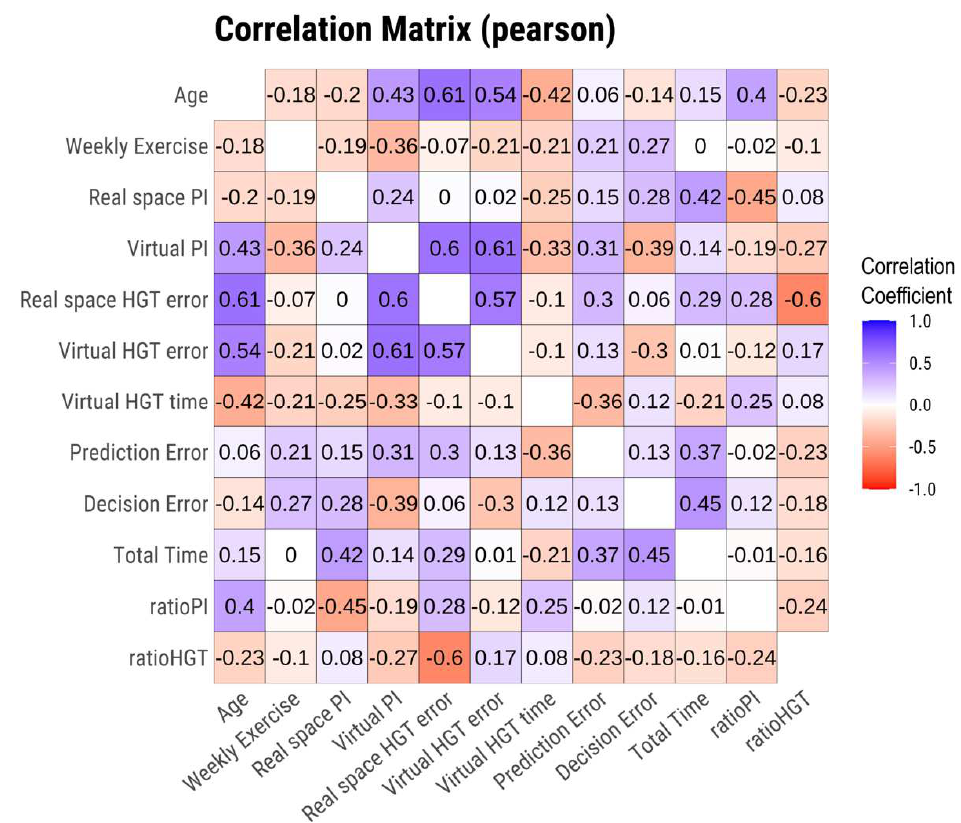
Figure 3. Group distribution and performance in the different tests. The group of participants had a wide age range ( a ) and was heterogeneous in the number of hours of exercise per week ( b ). Pa- rameters measured for the multiple-choice maze-like test ( c – e ), path integration ( f , g ), and hidden goal test ( h – j ). A great variability can be seen for all the tests, either real-space ( c – f , h ) or virtual